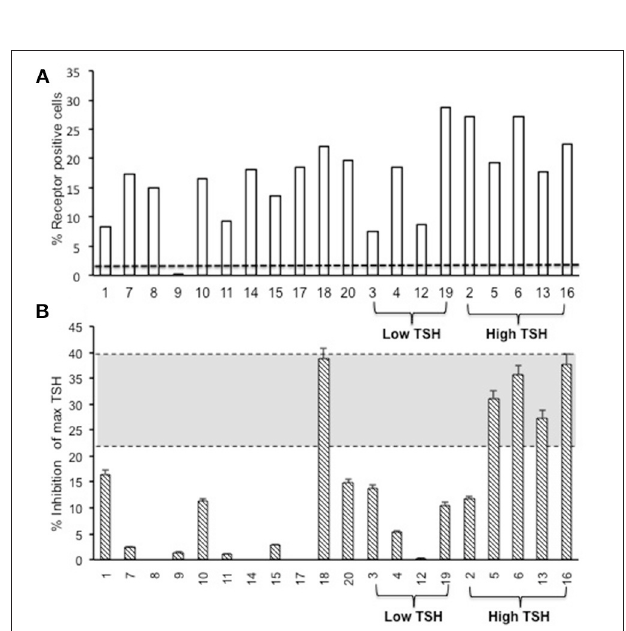
FIGURE 4 | Total TSH receptor antibodies in immunized mice. (A) Percentage of TSHR antibody: Flow cytometry was carried out at week 10 with serum samples from immunized and control animals using CHO-TSHR expressing cells to estimate TSH receptor binding antibodies. By this analysis, 95% of the immunized mice had conformational TSHR binding antibodies in their serum. The dotted line is the average response seen in the 10 control animals for TSHR antibodies ( ≤ 0.2%). (B) TSHR inhibiting antibody. To examine TSH blocking antibodies in the serum of immunized animals we used the TSHRGlo cells and performed the assay as described in M & M. K1-70 blocking monoclonal antibody was used as a positive control which gave a 39.7% inhibition to 60 µ U of bTSH in the assay, as indicated by the top dotted line. The lower cutoff (bottom dotted line) is 2 standard deviations above the average of the control mice, which was 20.4%. By these criteria we observed 5 out of the 20 hTSHR immunized animals had blocking antibodies at week 10 and 80% of these were mice with high